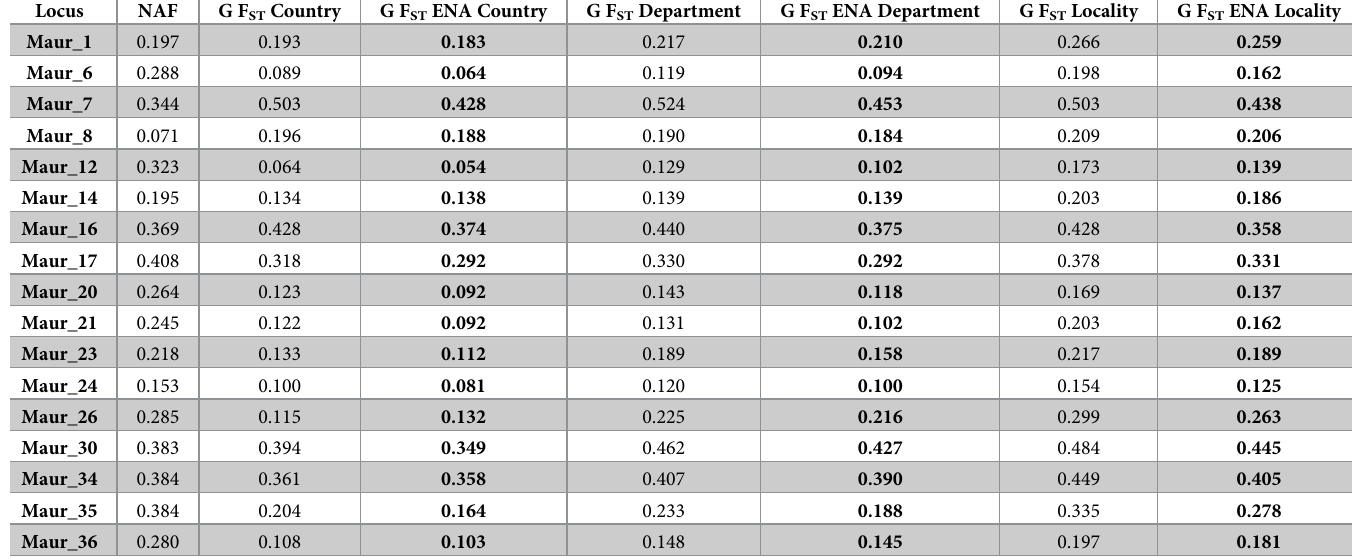
Table 3. Null alleles frequency (NAF) and global F ST (G F ST ), calculated with and without ENA correction, for null alleles in different scales (Country, Department and Locality). Locus NAF